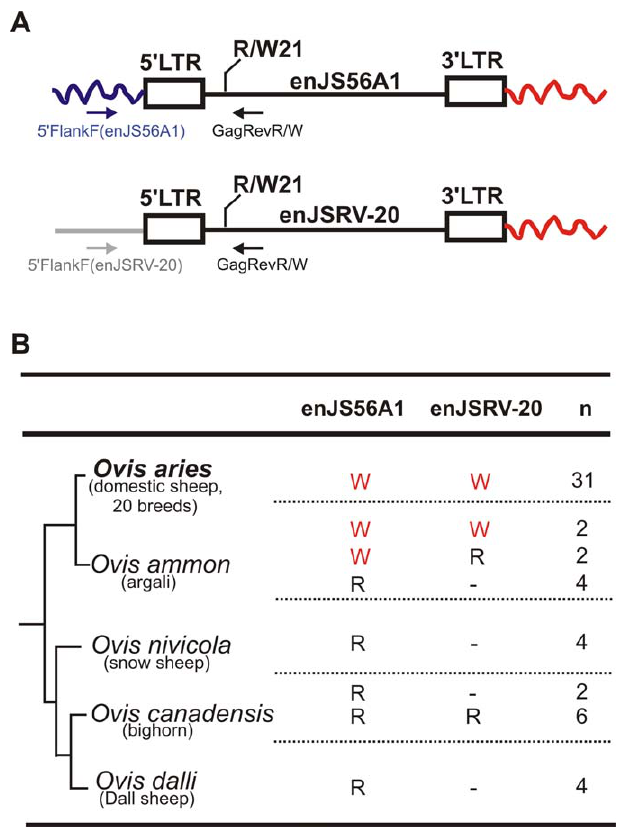
Figure 3. Fixation of R21W Substitution in enJS56A1 and enJSRV-20 Gag in the Domestic Sheep (A) Schematic representation of the PCRs used to specifically amplify the 5 9 LTR and the proximal region of gag of enJS56A1 or enJSRV-20. (B) Schematic representation of the presence or absence of the transdominant genotypes of enJS56A1 and/or enJSRV-20 in Ovis species. The phylogenetic tree indicates only relationships and is not propor- tional to